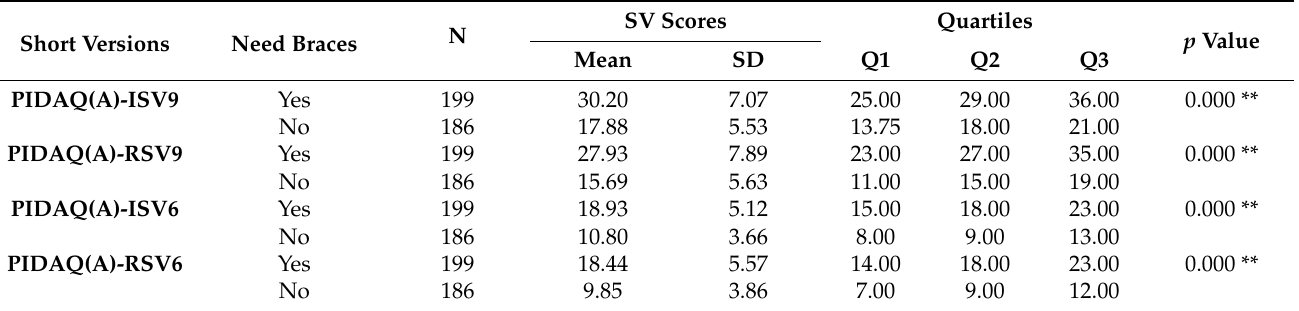
Table 13. The discriminant validity: associations of all Arabic PIDAQ short versions with regards to ranking the need for braces (n = 385).